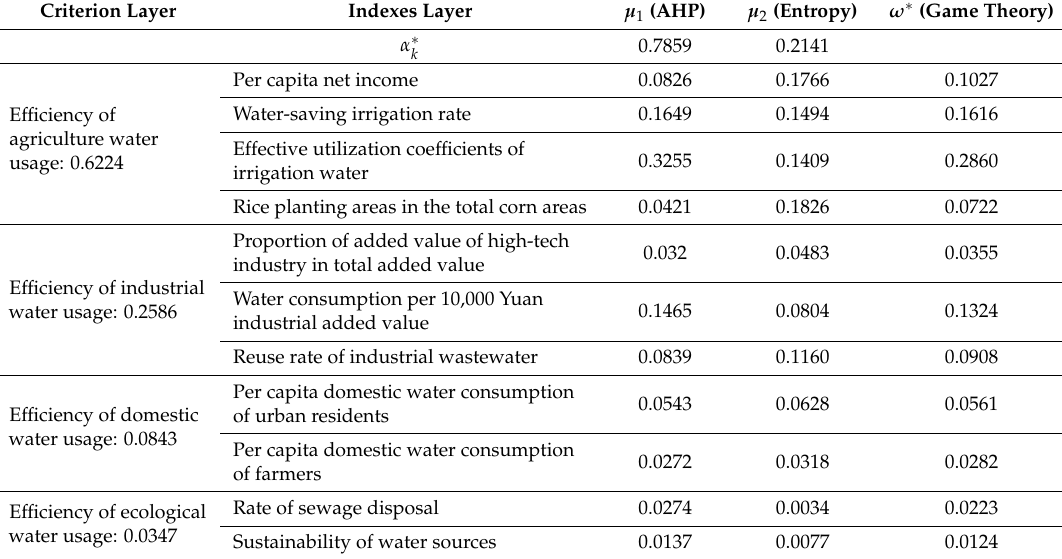
Table 7. Comprehensive weight values of evaluation